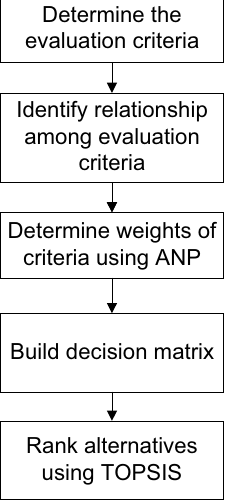
Fig. 1. Overall procedure for renewable